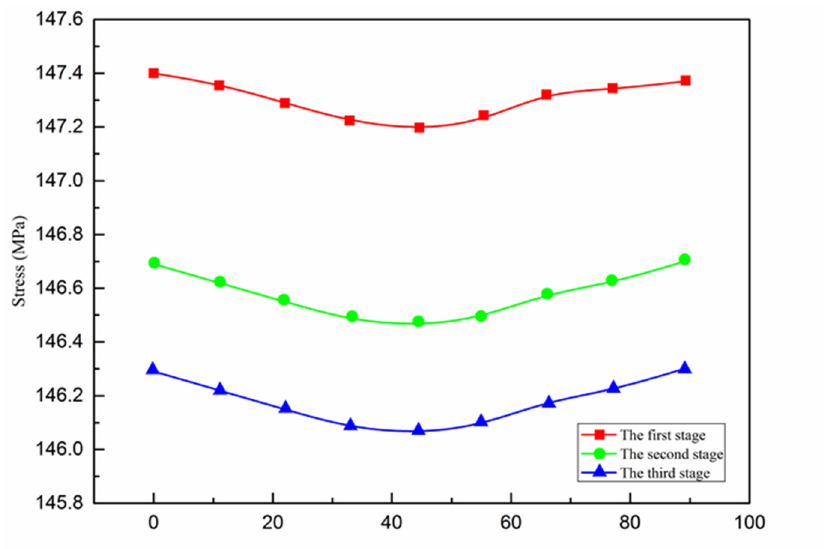
Figure 26. Stress along the centerline of the long − span converter station steel structure during each of the three lifting stages.